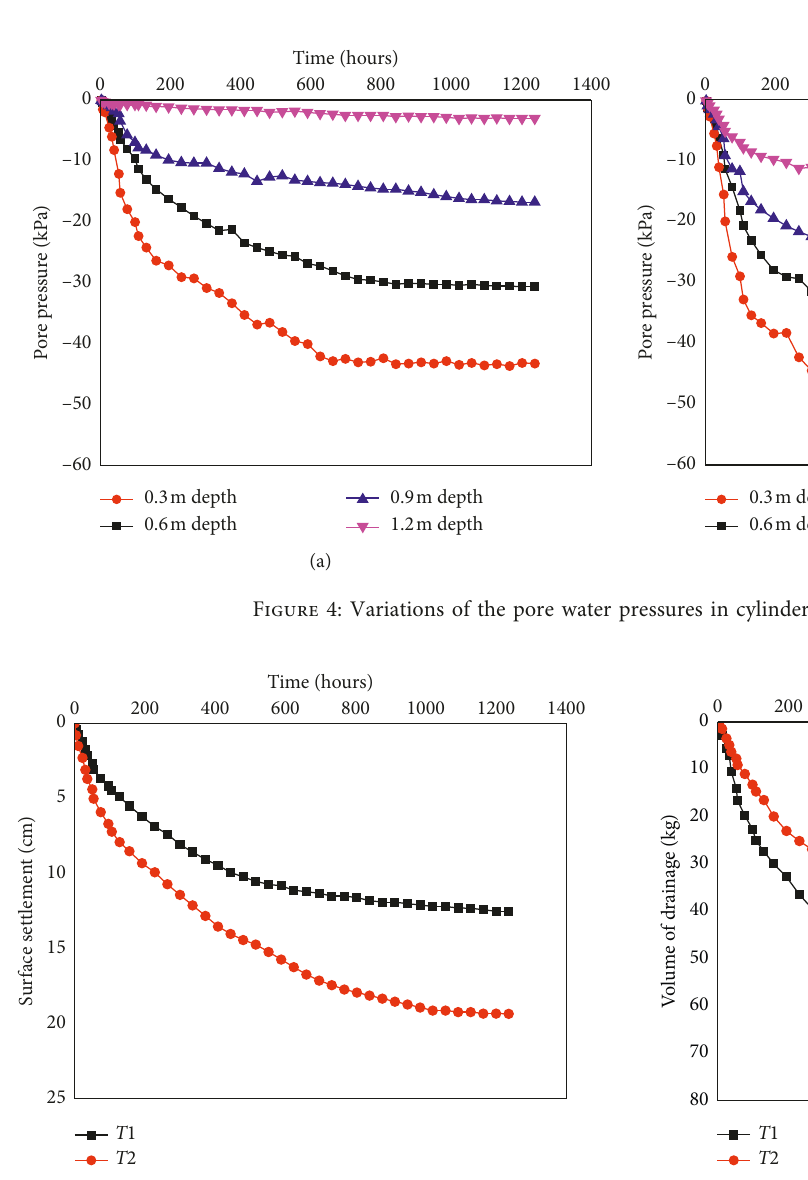
Figure 6: Volumes of extracted water plotted as functions of time for cylinders T 1 and T 2.